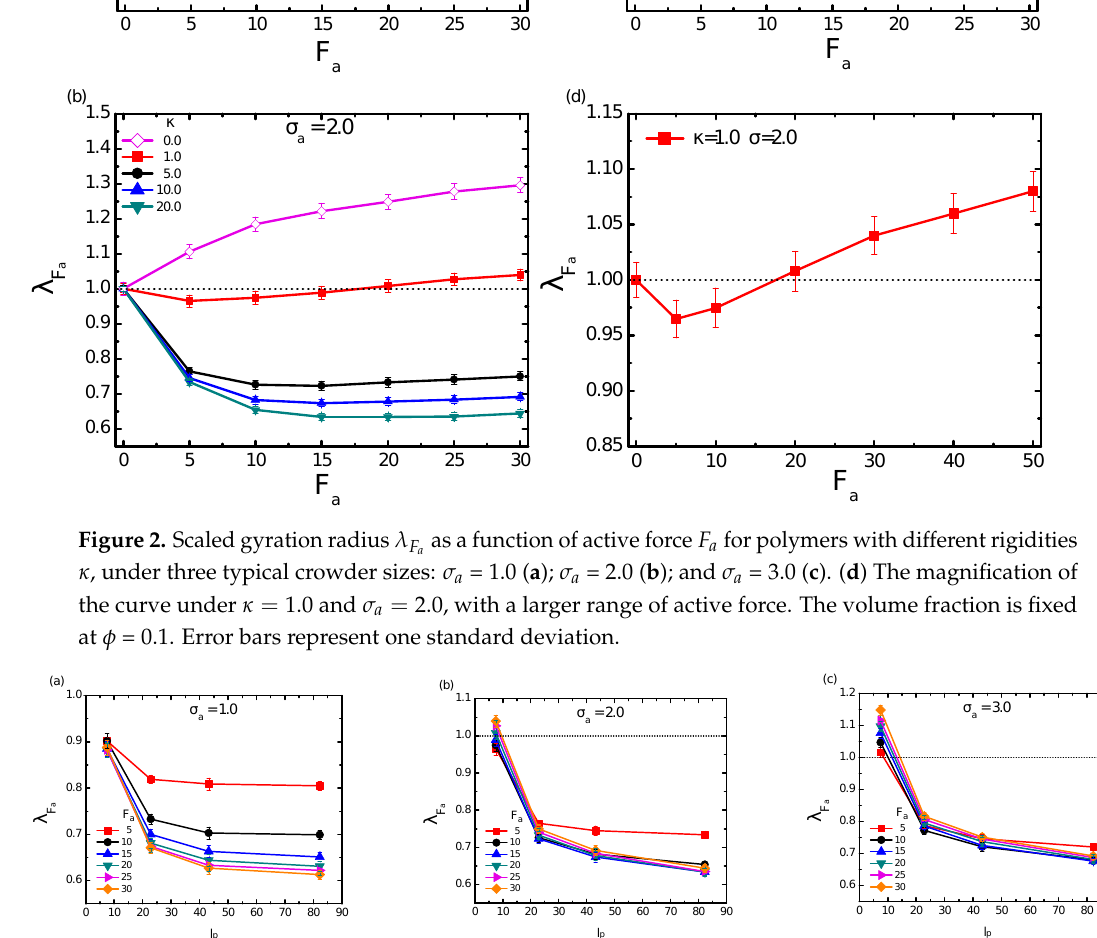
on the persistence length l p of the probed a